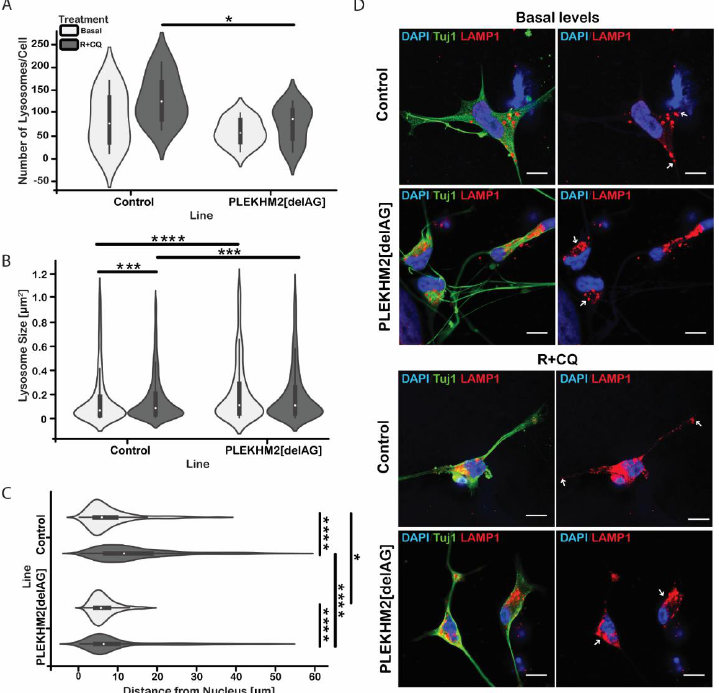
Figure 5. Lysosomal distribution. ( A ) Number of lysosomes within each cell. The interquartile range (IQR) is denoted by the black rectangle, white dots denote the median value * p = 0.0206 by one-way ANOVA Sidak’s multiple -comparisons test. ( B ) Lysosome size distribution in baseline and follow- ing stress induction. *** p < 0.007, **** p < 0.0001 by one-way ANOVA with Kruskal – Wallis multiple- comparisons test. ( C ) The distance of lysosomes from the nucleus is measured. * p = 0.0213, **** p < 0.0001 by one-way ANOVA with Kruskal – Wallis multiple-comparisons test. ( D ) Representative im- ages of cells during basal conditions and following R + CQ treatment. White arrows point to lyso- somes far from the nucleus in control cultures or perinuclear in PLEKHM2[delAG] cultures. n = 11 – 14 cells from two independent experiments. Scale bar — 10 µm. Blue — DAPI, green —TUJ1α, red— LAMP1.